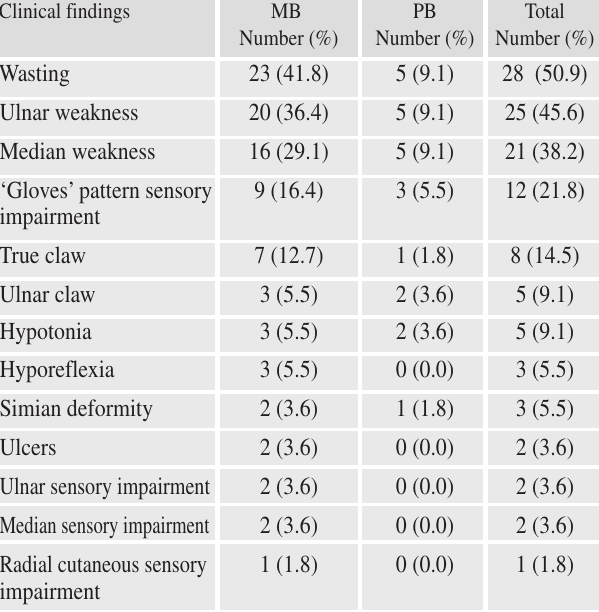
Table II: Neurological findings of leprosy in upper limbs (n=55)! ! Clinical findings!